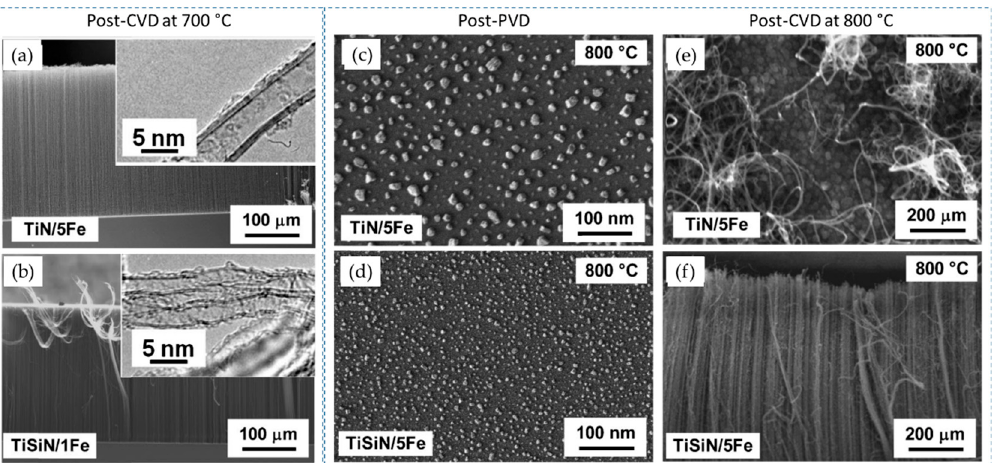
Figure 11. SEM micrographs of VACNT on ( a ) TiN with 5nm Fe and ( b ) TiSiN with 1nm Fe at 700 °C; Post-annealing catalyst restructuration on ( c ) TiN with 5nm Fe film or ( d ) TiSiN with 5nm Fe film at 800 °C, whereas ( e , f ) present the same after CNT growth at 800 °C, respectively; Reprinted with permission from Yang, physica status solidi ( b ) basic solid-state physics; Ref. [89] copyright 2014, John Wiley and Sons.